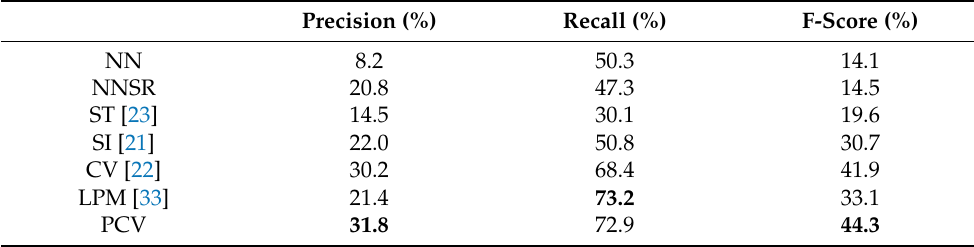
Table 3. Correspondence grouping performance of tested methods on the U3OR dataset.